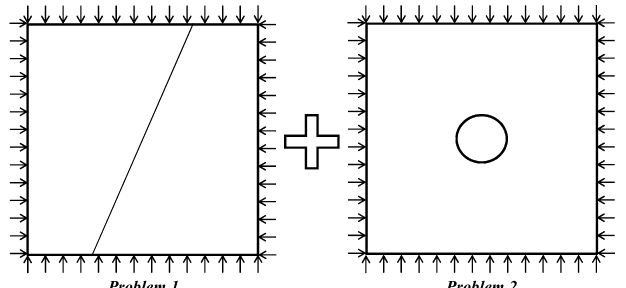
Figure 11. Calculation model.